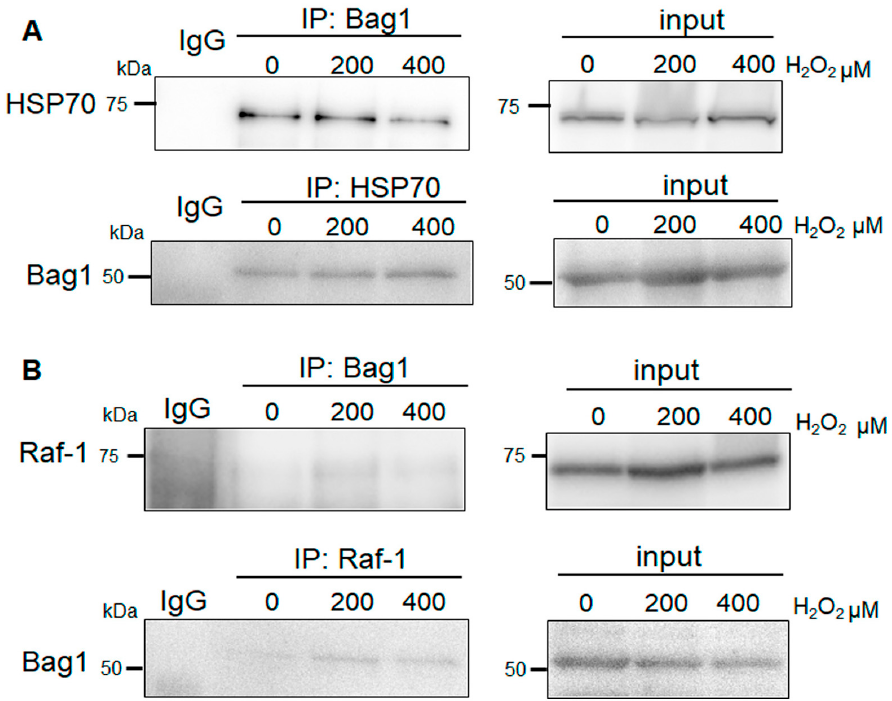
Figure 4. ( A ) Immunoprecipitation (IP) of Bag-1 and HSP70 from NP cells cultured with H 2 O 2 from 0–400 μ M for 24 h followed by Western blot analysis using anti-HSP70 and anti-Bag-1. Bag-1 bound to HSP70 under all conditions. Pre-immune rabbit IgG was used as a negative control for the IP assays. ( B ) Immunoprecipitation (IP) of Bag-1 and Raf-1 from NP cells cultured under H 2 O 2 from 0–400 μ M for 24 h followed by Western blot analysis using anti-Raf-1 and anti-Bag-1 antibodies. Pulldown of Bag-1 did not show obvious co-immunoprecipitation of Raf-1. Pulldown of Raf-1 did not show co-immunoprecipitation of Bag-1 under H 2 O 2 -free conditions and showed an exceedingly faint co-precipitation of Bag-1 under H 2 O 2 treatment. Pre-immune rabbit IgG was used as a negative control for the IP assays.